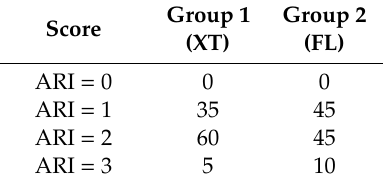
Table 3. Frequencies of adhesive remnant index (ARI) indexes for both groups.